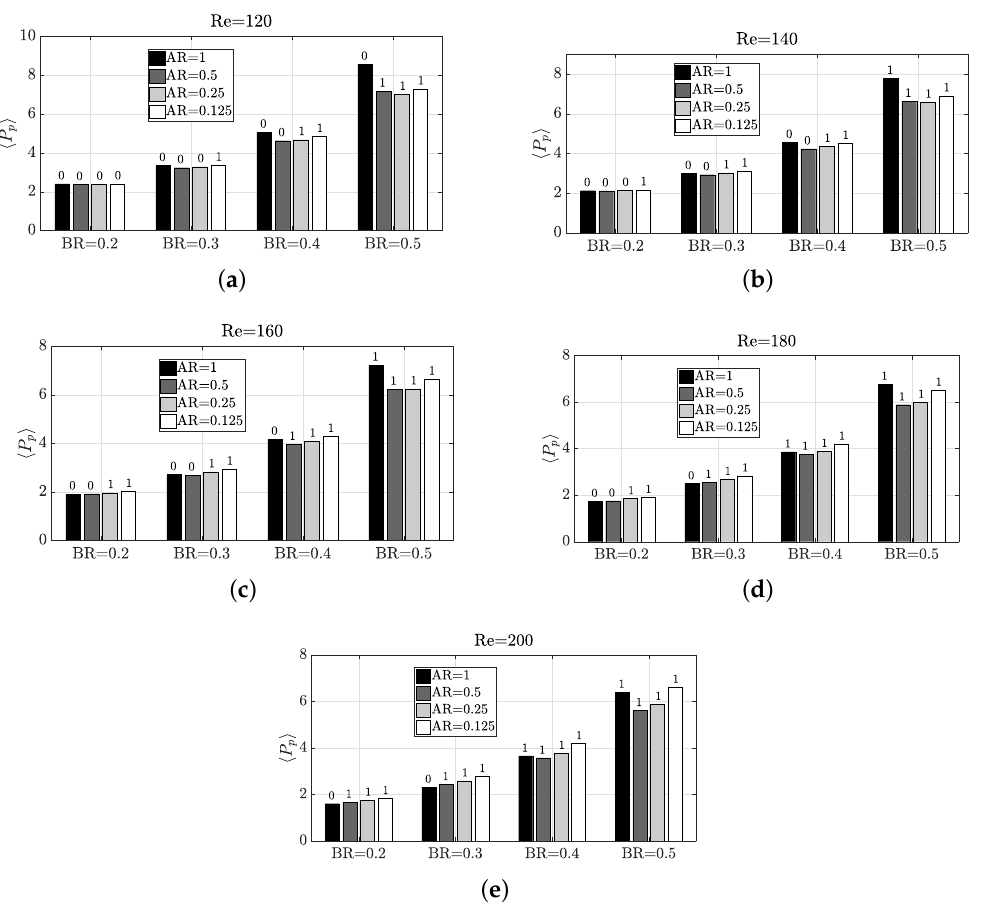
Figure 13. Impact of Reynolds number and geometry on the pumping power (cid:104) P p (cid:105) . The number on top of each bar indicates whether the configuration presents vortex shedding (1) or not